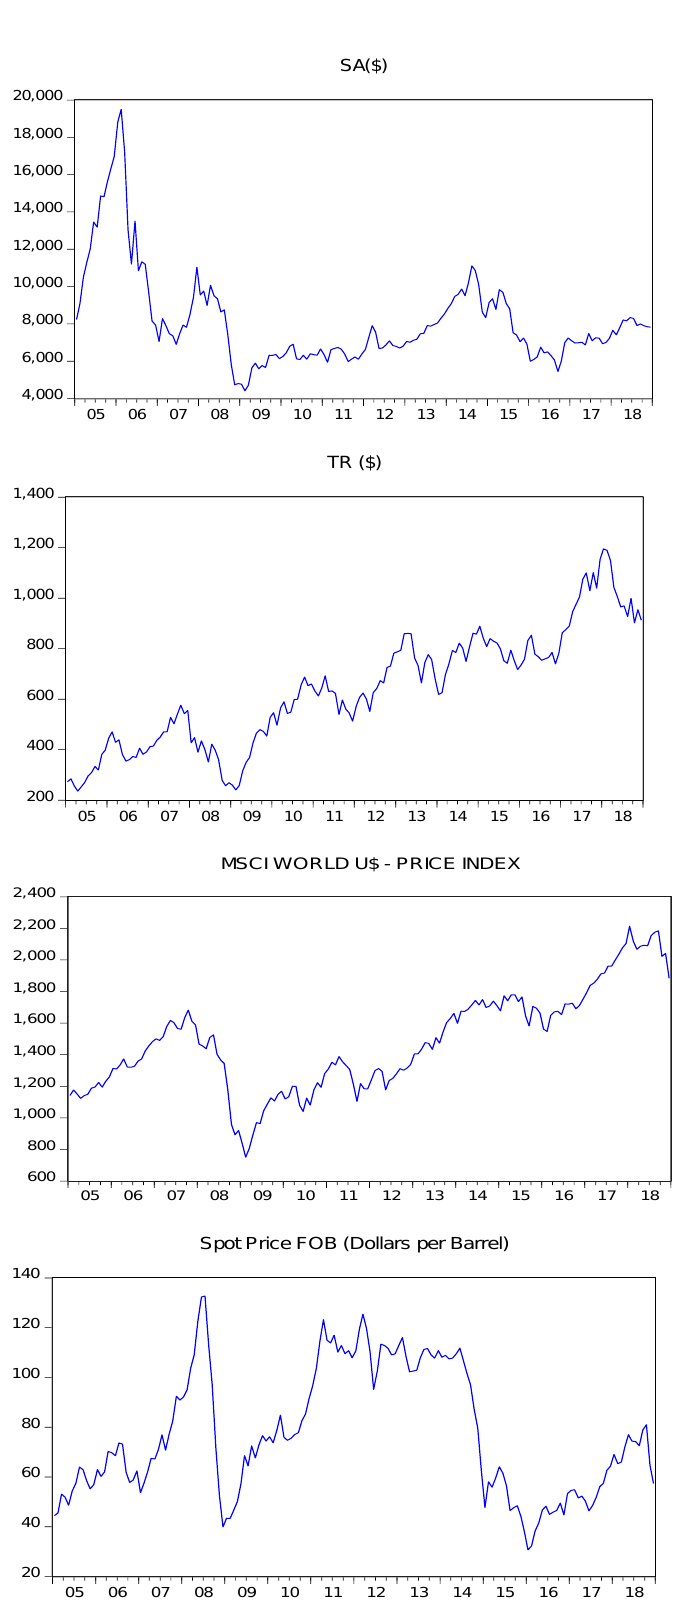
Figure 1. Stock price indices and the Brent Oil price: January 2005 – December 2018. As observed in Figure 2, the excess stock returns of Saudi Arabia, Turkey, and the World Price Index were highly volatile during the 2008 – 2009 financial crisis. Brent oil